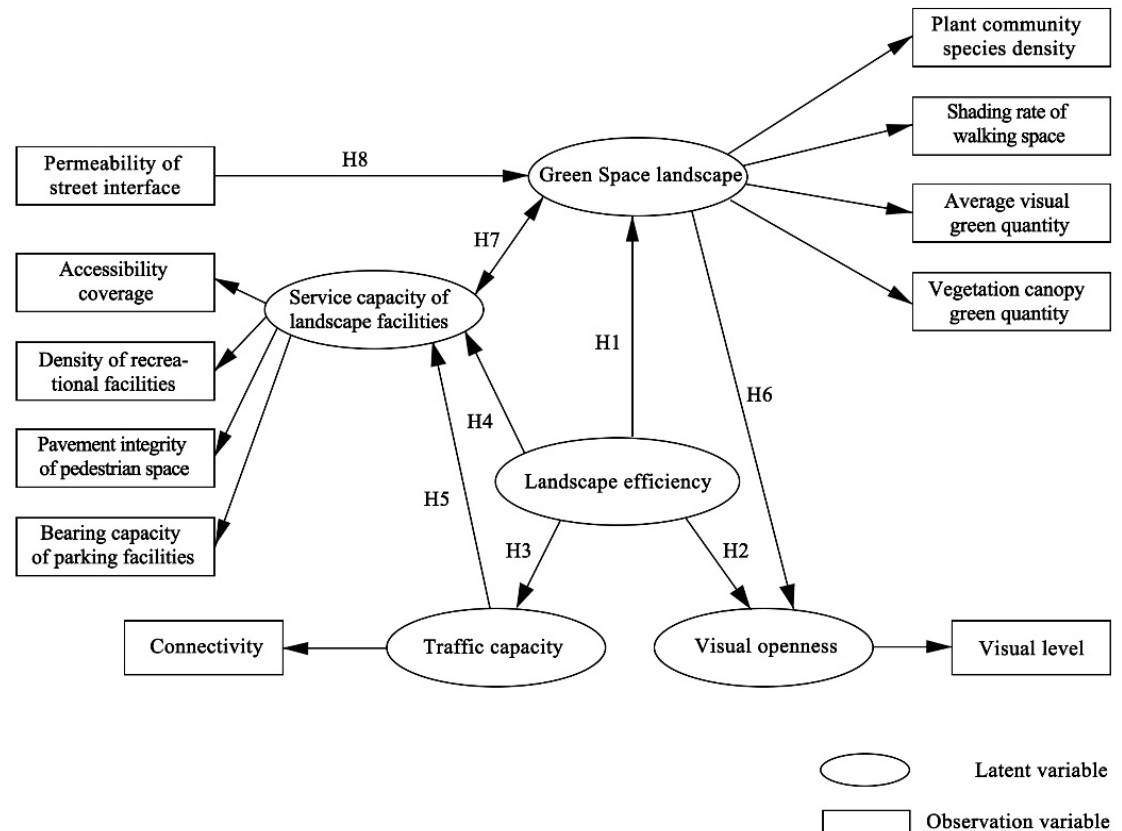
Figure 2. Initial model and theoretical hypotheses of the landscape efficiency of subway station en- trances.